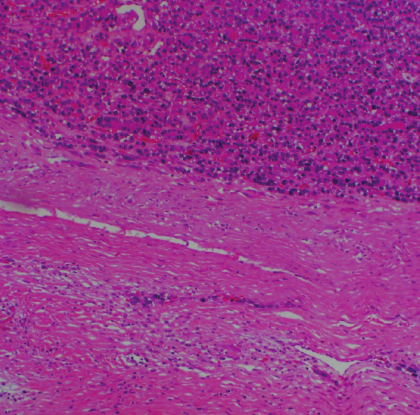
Figure 6: Hematoxylin and Eosin showing dark stained colloid (classic variant papillary thyroid cancer) (the third